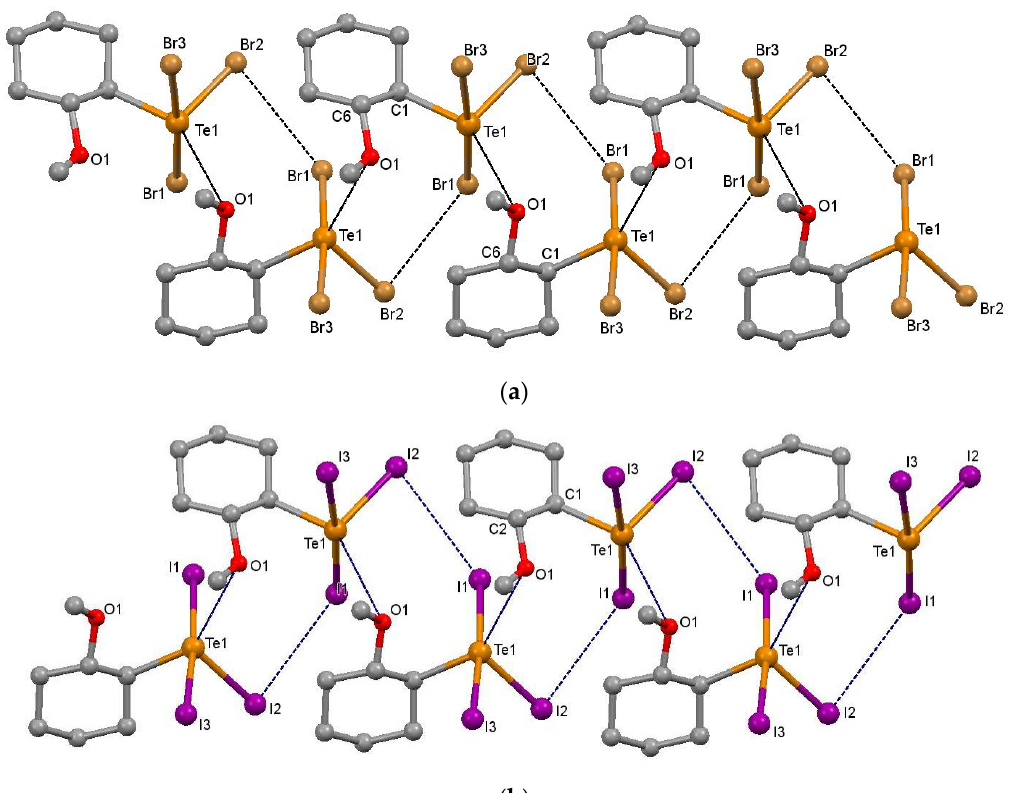
Figure 4. Fragment of packing in the isostructural crystal of 7 ( a ) and 8 ( b ). Showing the Te—O ChB and X—X (X = Br, I) XBs stabilized catemer chain. Hydrogen atoms are omitted for clarity. Selected distances (Å) in 7 : (intramolecular): Te1-O1 2.826, Te1-Br3 2.679(2), Te1-Br1 2.639(2), Te1-Br2 2.491(2); (intermolecular) Te1-O1 3.422(9), Br2-Br1 3.778(2); Selected distances (Å) in 8 (intramolecular): Te1-O1 2.915(6), I1-Te1 2.9205(6), Te1-I3 2.8958(7), Te1-I2 2.7165(7) (intermolecular): Te1-O1 3.604(5), I2-I1 3.9888(7). Notice the obscene of Te—halogen intermolecular